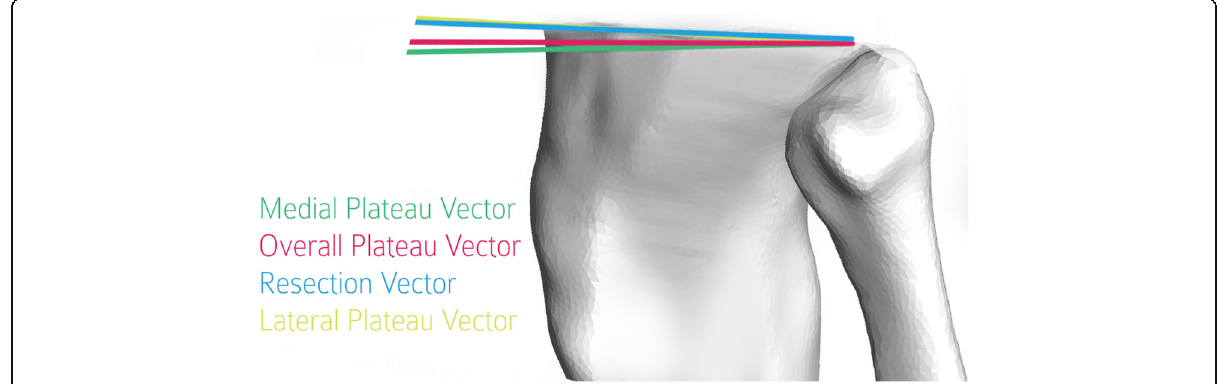
Fig. 3 Relative flexion measured after projection on sagittal plane (Subject 7). [As in Fig. 2, the directions are shown eminating from a single point to facilitate visualization of measurements.]